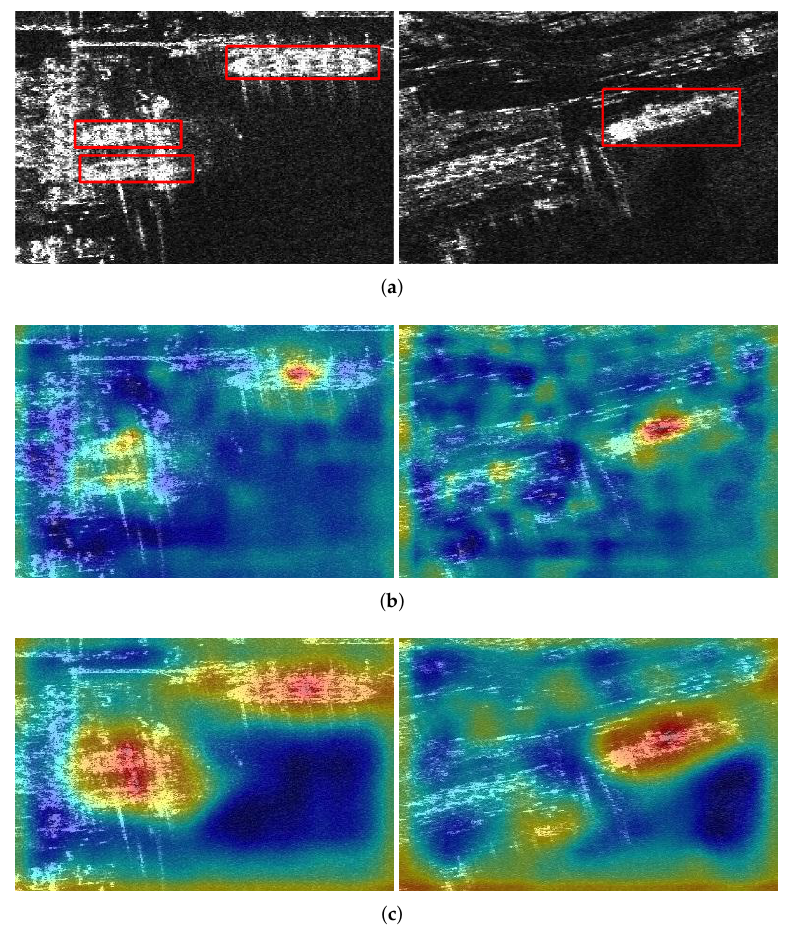
Figure 14. Visualization of the confidence maps. ( a ) Ground truth. ( b ) Visualization of the baseline without SIA. ( c ) Visualization of the baseline with